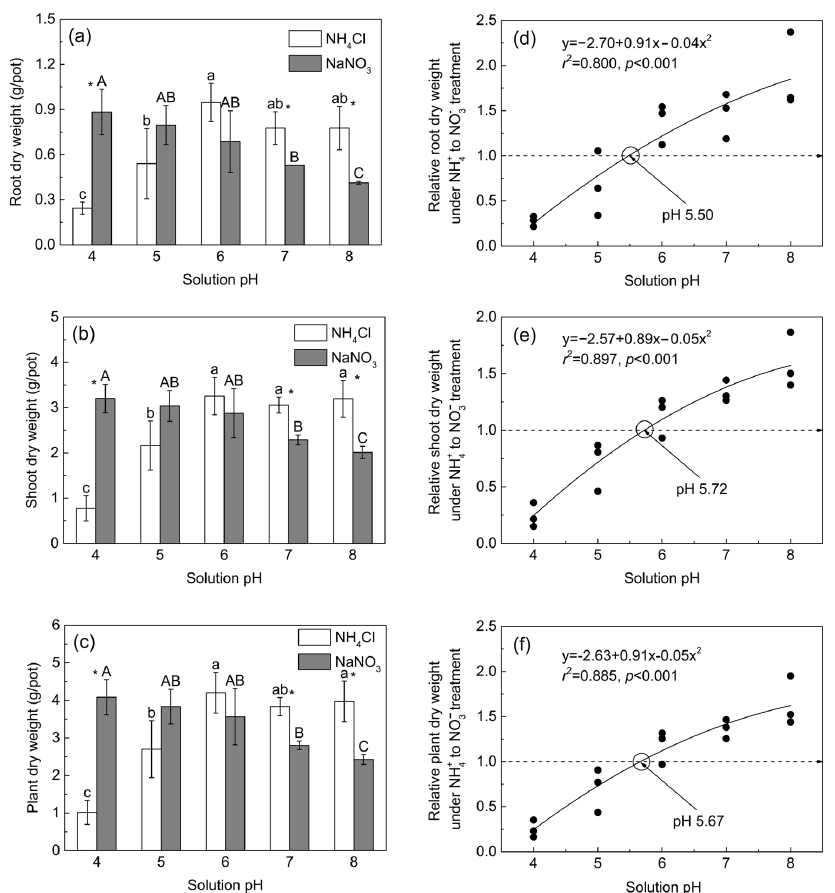
Figure 6. Effect of solution pH on the growth response of maize to ammonium (NH 4+ ) and nitrate (NO 3 − ) fertilizers under hydroponic conditions. ( a – c ) Dry weights of the root ( a ), shoot ( b ), and total plant ( c ). ( d – f ) Relative dry weights of the root ( d ), shoot ( e ), and total plant ( f ). Maize seedlings were harvested after 15 days of growth. Relative root, shoot, and plant dry weights of maize were calculated as the ratio of dry weight under NH 4+ treatment to that under NO 3 − treatment. Different lowercase and capital letters above bars indicate significant differences among different solution pHs under NH 4+ and NO 3 − treatments, respectively. Asterisks indicate significant differences between NH 4+ and NO 3 − treatments at the same solution